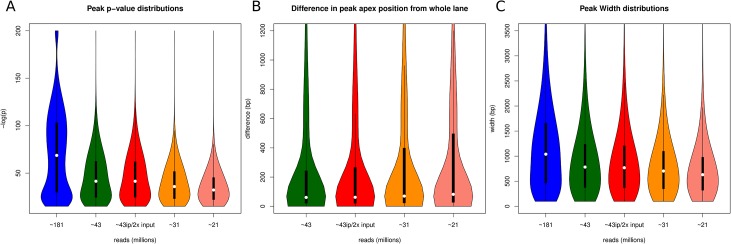
Peak characteristics.A) P-values for detected peaks shift towards reduced significance as multiplexing increases. B) The difference in peak apex position of peaks detected in multiplexed libraries to peak apex positions of peaks detected in the non-multiplexed library shows consistent difference across all multiplexed levels while increasing variability as multiplexing increases. C) Peak width distributions show a marginal reduction across multiplex levels.